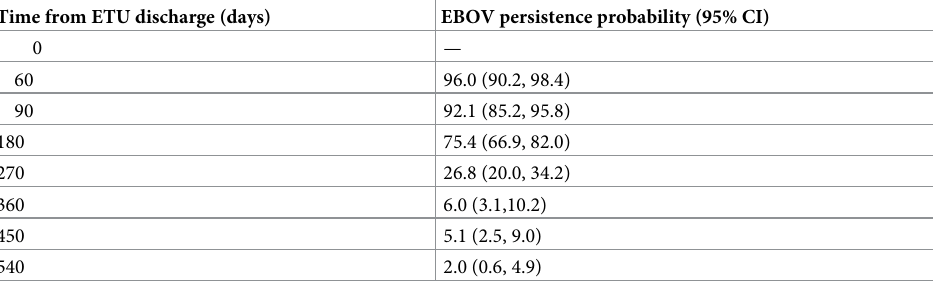
Table 2. Kaplan–Meier non-parametric interval-censored probability estimates of Ebola virus RNA persistence in